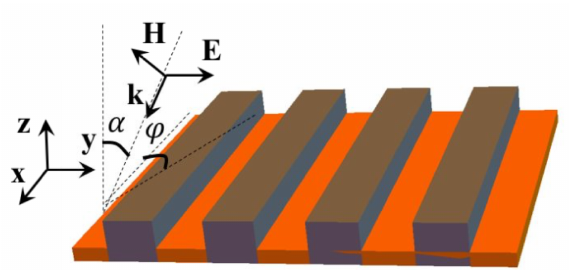
Figure 13. Scheme of the periodic polymethylmethacrylate (PMMA) bars on gold substrate, from [17].